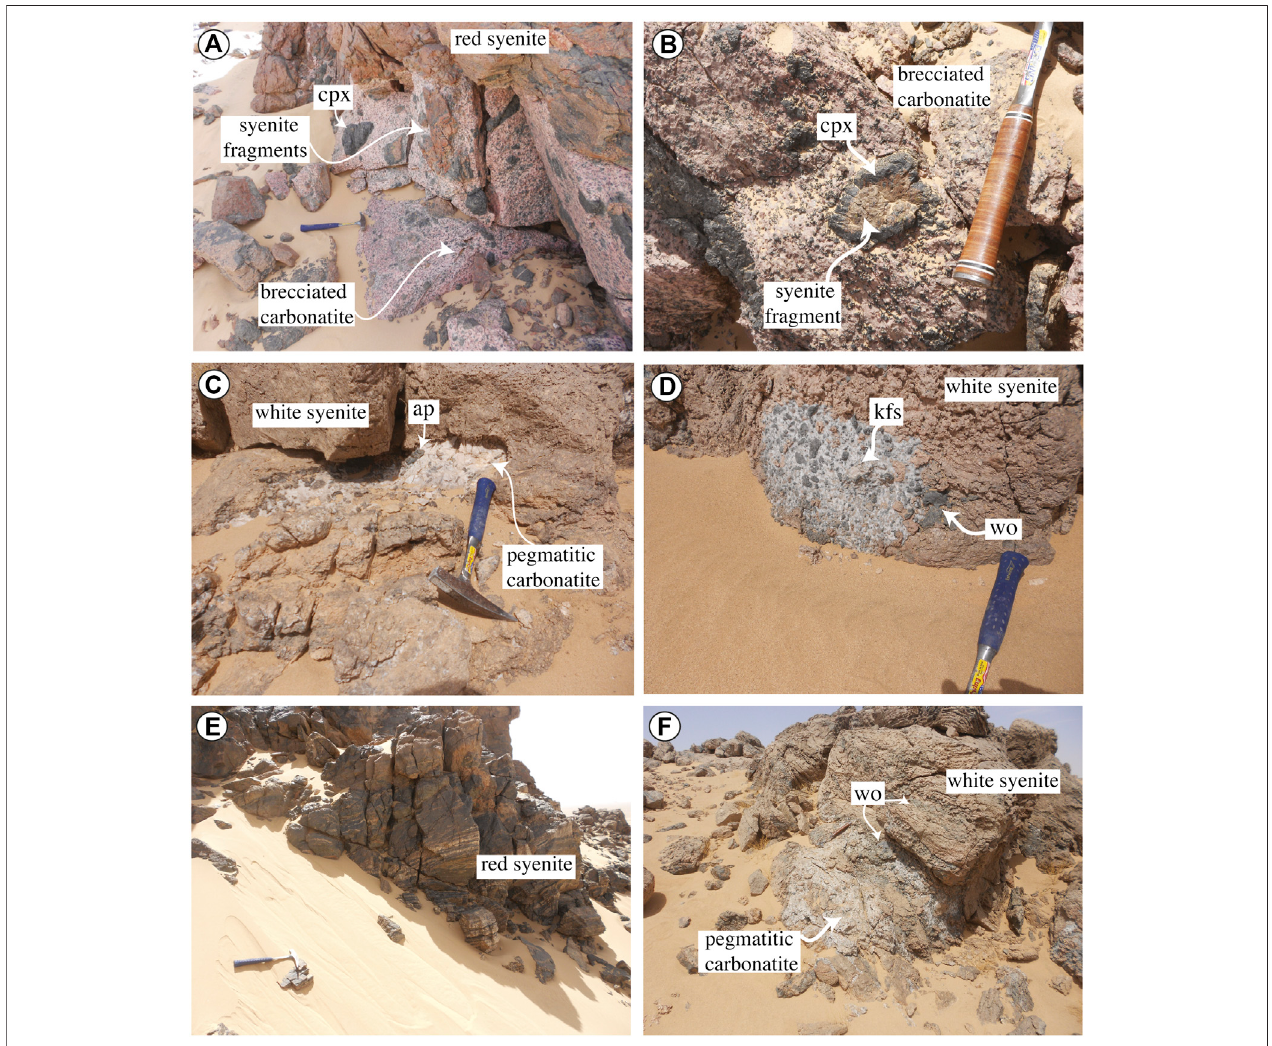
FIGURE2| FieldphotographsofthealkalinesyenitesandcarbonatitesinthethreesectorsofIhouhaouenearea. (A) NorthwadiTirahartbrecciatedcarbonatitevein with clinopyroxene (cpx) and syenite fragments intruding a red syenite. (B) Oued Ihouhaouene syenite fragment surrounded by clinopyroxene aureole in brecciated carbonatite. (C) South wadi Tirahart pegmatitic carbonatite with apatite (ap) crystals in white syenite. (D) South wadi Tirahart carbonatite pocket rich in wollastonite (wo) and K-feldspar (kfs) in white syenite. (E) North wadi Tirahart layered red syenite with light K-feldspar levels and dark clinopyroxene levels. ( F) South wadi Tirahart pegmatitic carbonatite vein intruding a white syenite rich in wollastonite levels.